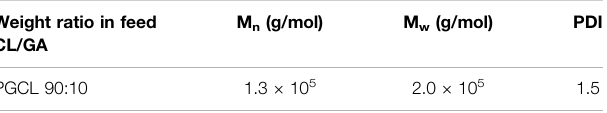
TABLE 2 | GPC results of PGCL. Weight ratio in feed